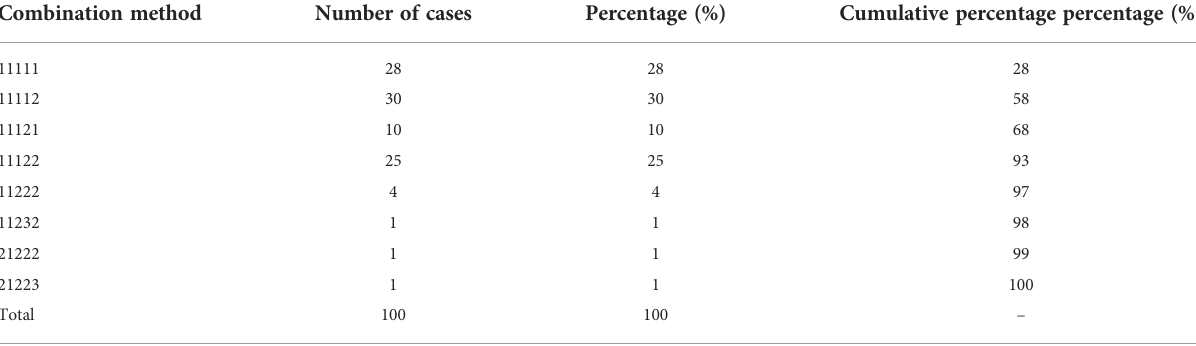
TABLE 2 Distribution of EQ-5D-3L measurement